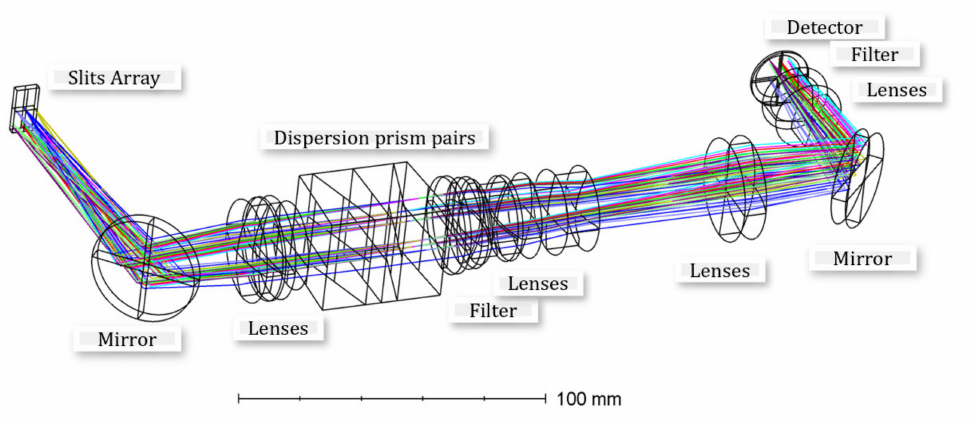
Figure 3. Optical system of uniformly distributed-slit array coded spectral imaging system.